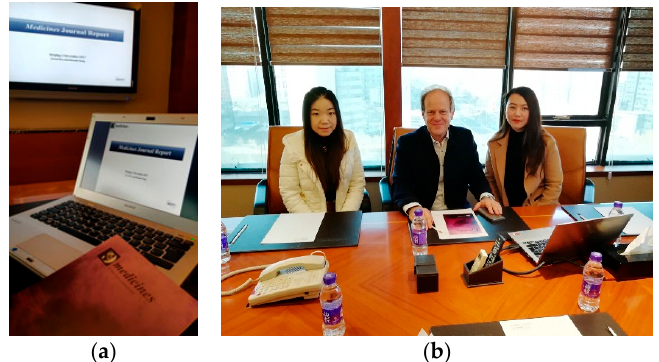
Figure 30. ( a ) Medicines journal report; ( b ) From left to right: Ms. Bonnie Yang, Managing Editor,